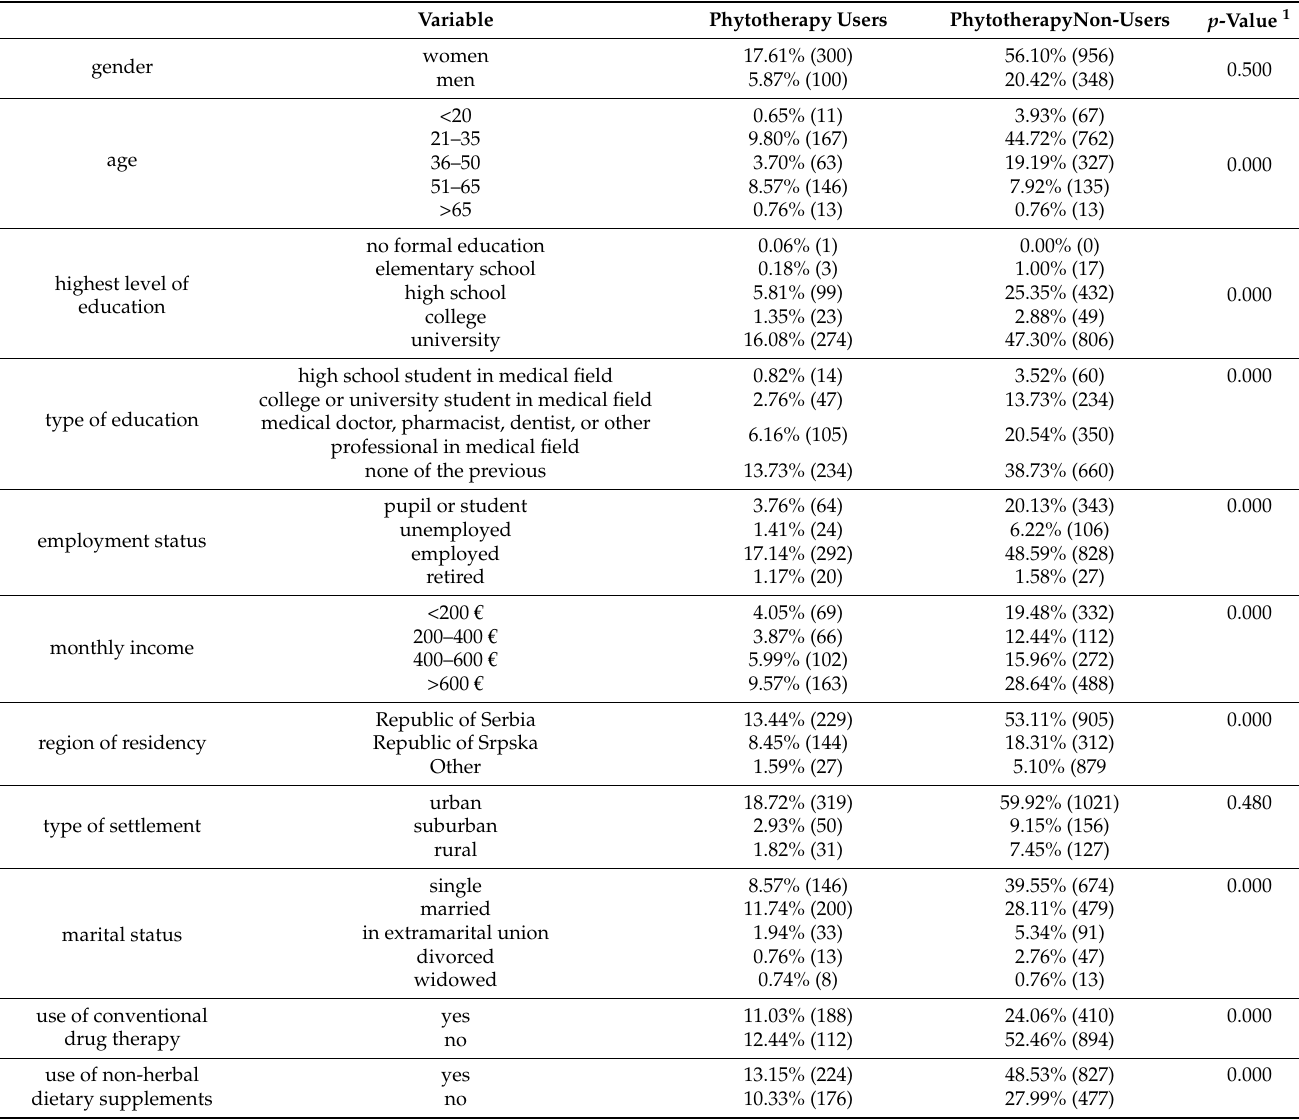
Table 4. Comparison of socio-demographic characteristics of phytotherapy users and